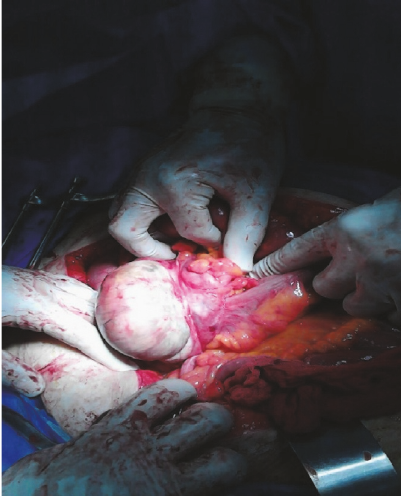
Figure 1: Ischemic field (7 × 5cm) on the cecal lateral wall.